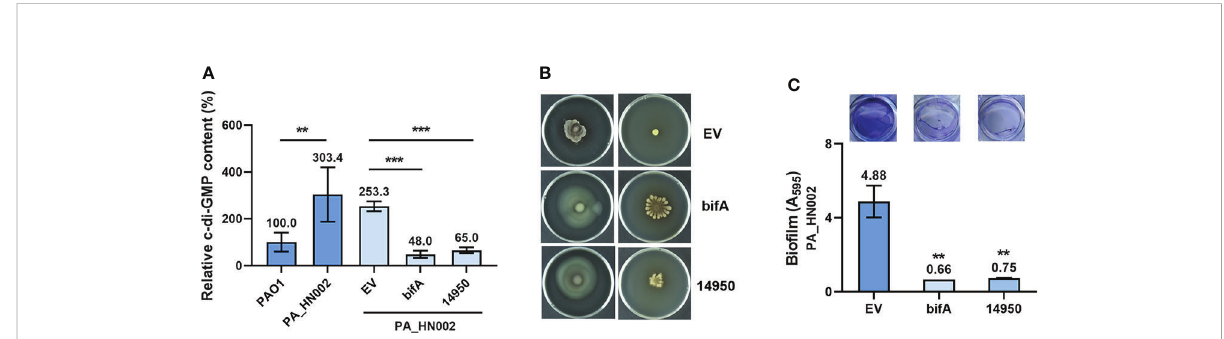
FIGURE 2 PA_HN002 displayed a c-di-GMP-dependent transition of motile-sessile lifestyles. (A) LC-MS quanti fi cation of the intracellular c-di-GMP content in PAO1, PA_HN002 and PA_HN002 expressing plasmid-carried PDE genes bifA or W909_14950 (14950). Relative content was shown in the PA_HN002 strains compared to PAO1. (B) Swimming (left) and swarming (right) motilities of PA_HN002 and PA_HN002 with expression of the PDE genes bifA and W909_14950 (14950). (C) Bio fi lm formation of PA_HN002 and PA_HN002 with expression of the PDE genes bifA and W909_14950 (14950). ** P <0.01, *** P <0.001 based on Student ’ s t -test in (A) and one-way ANOVA compared to the EV (empty vector) group in (C)